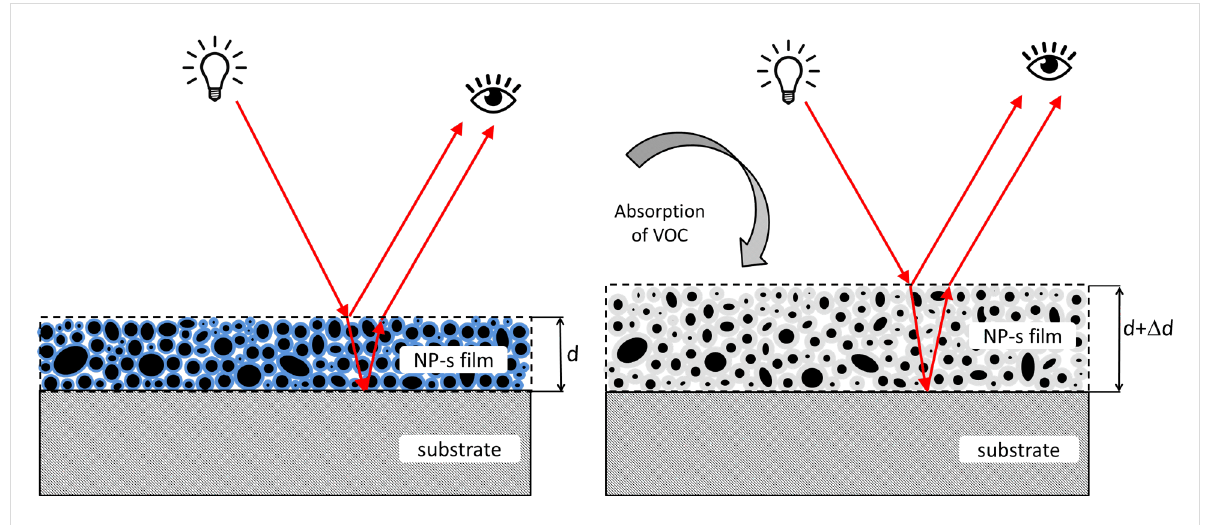
Figure 2: Working principle of the sensor element: the light reflected from the surface of the film and from the film/substrate interface will interfere. Left: situation before absorption of VOCs; right: situation after absorption of VOCs. The optical path length is changed by the absorbed VOC mole- cules due to the twofold mechanism: (i) physical swelling of the film ( d → d + Δ d ) and (ii) decrease of the refractive index of the film ( n → n − Δ n ). Black circles mark NPs; blue area on the left panel represents PTSA; and grey area on the right panel represents a mixture of PTSA and VOC.